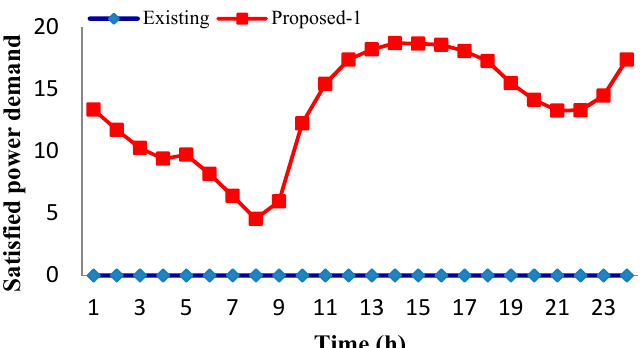
Figure 12. Comparison of satisfied power demand management between proposed 1 and existing scenario over 24 h time horizon.